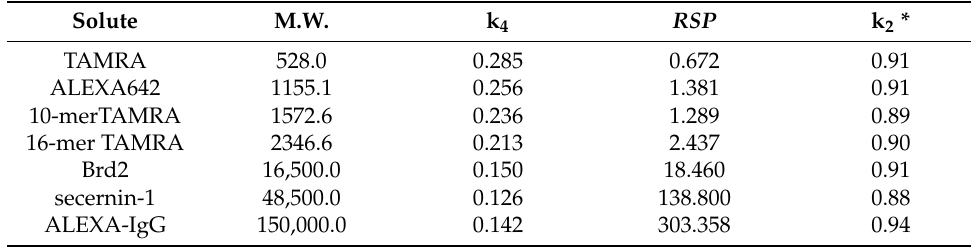
Table 2. Obtained k 4 , RSP and k 2 values for the